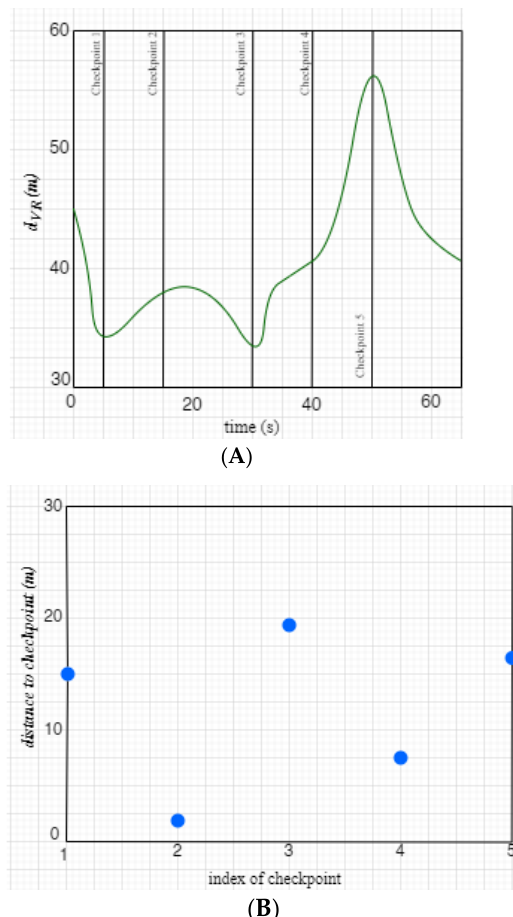
Figure 14. ( A ) time(s); ( B ) Index of checkpoint. Simulated and numerical passing probability P M vs. challenges K.